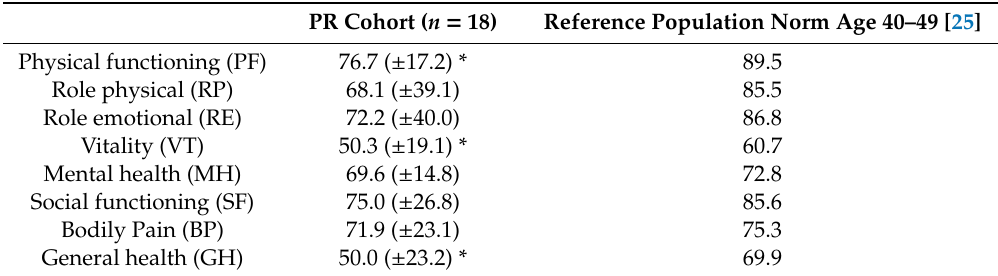
Table 4. Subscales of Short Form-36 Health Survey at long-term follow-up †